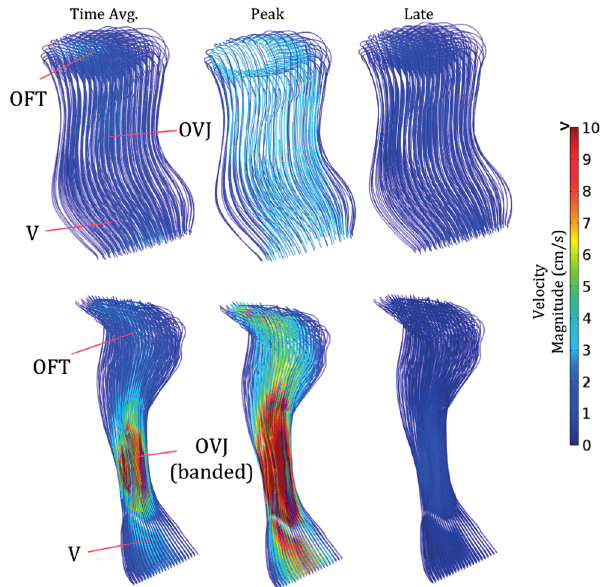
Figure 4. Velocity magnitude streamlines for (top) control chick hearts and (bottom) OFT banded chick hearts at the time-averaged flow velocity, peak flow conditions and late in the cardiac cycle during retrograde flow. V, ventricle; OVJ, OFT/ventricle junction; OFT, outflow tract.